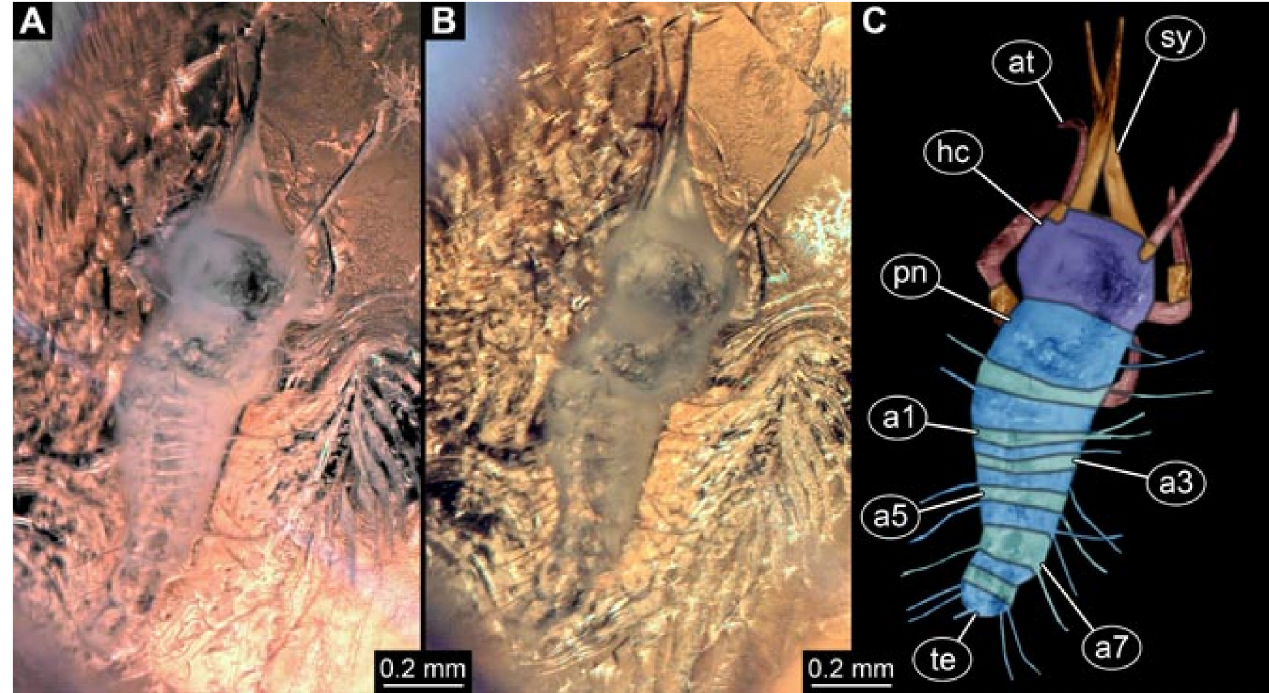
Figure 3. Specimen 5822 (Gröhn 7512); Baltic amber. ( A ) Dorsal view, cross-polarised coaxial light. ( B ) Dorsal view, unpolarised ring light. ( C ) Dorsal view, colour-marked. Abbreviations: a1–a7 = abdomen segments 1–7; at = antenna; hc = head capsule; pn = pronotum; sy = stylet; te = trunk